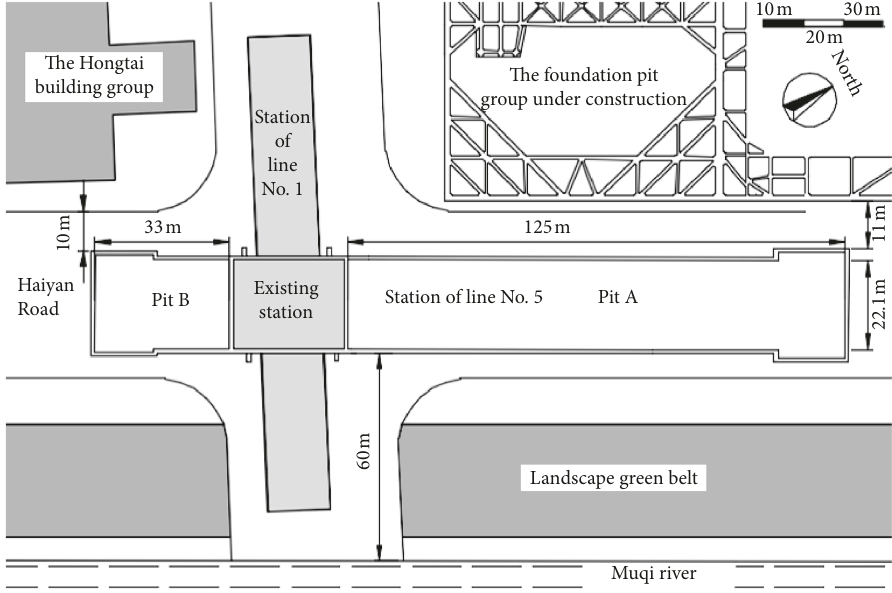
Figure 1: Plan view of the foundation pit of the Haiyan Road station of Line No.